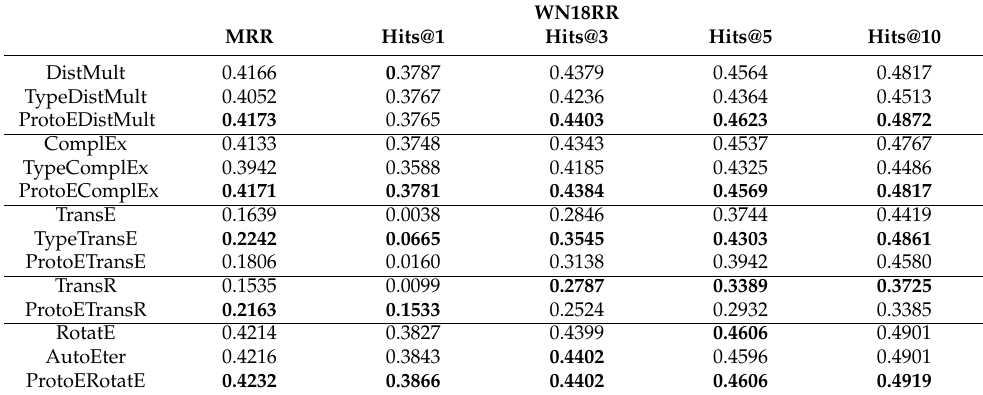
Table 3. Experimental results for WN18RR. Best values are indicated in bold.